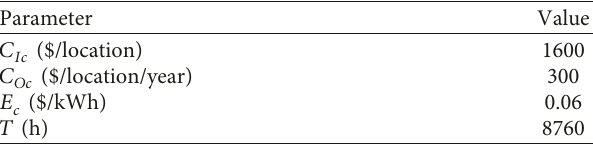
Table 1: The values of cost